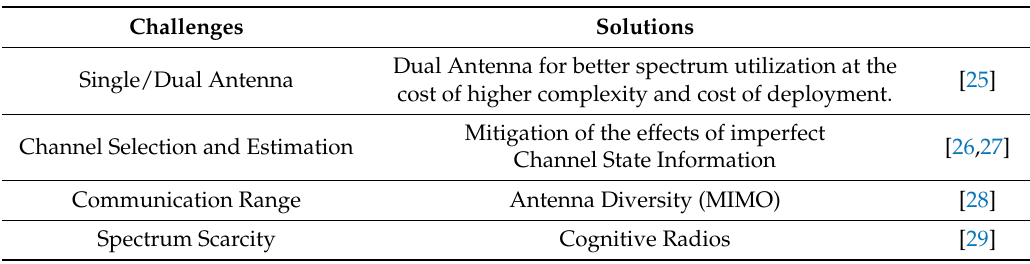
Table 1. Physical